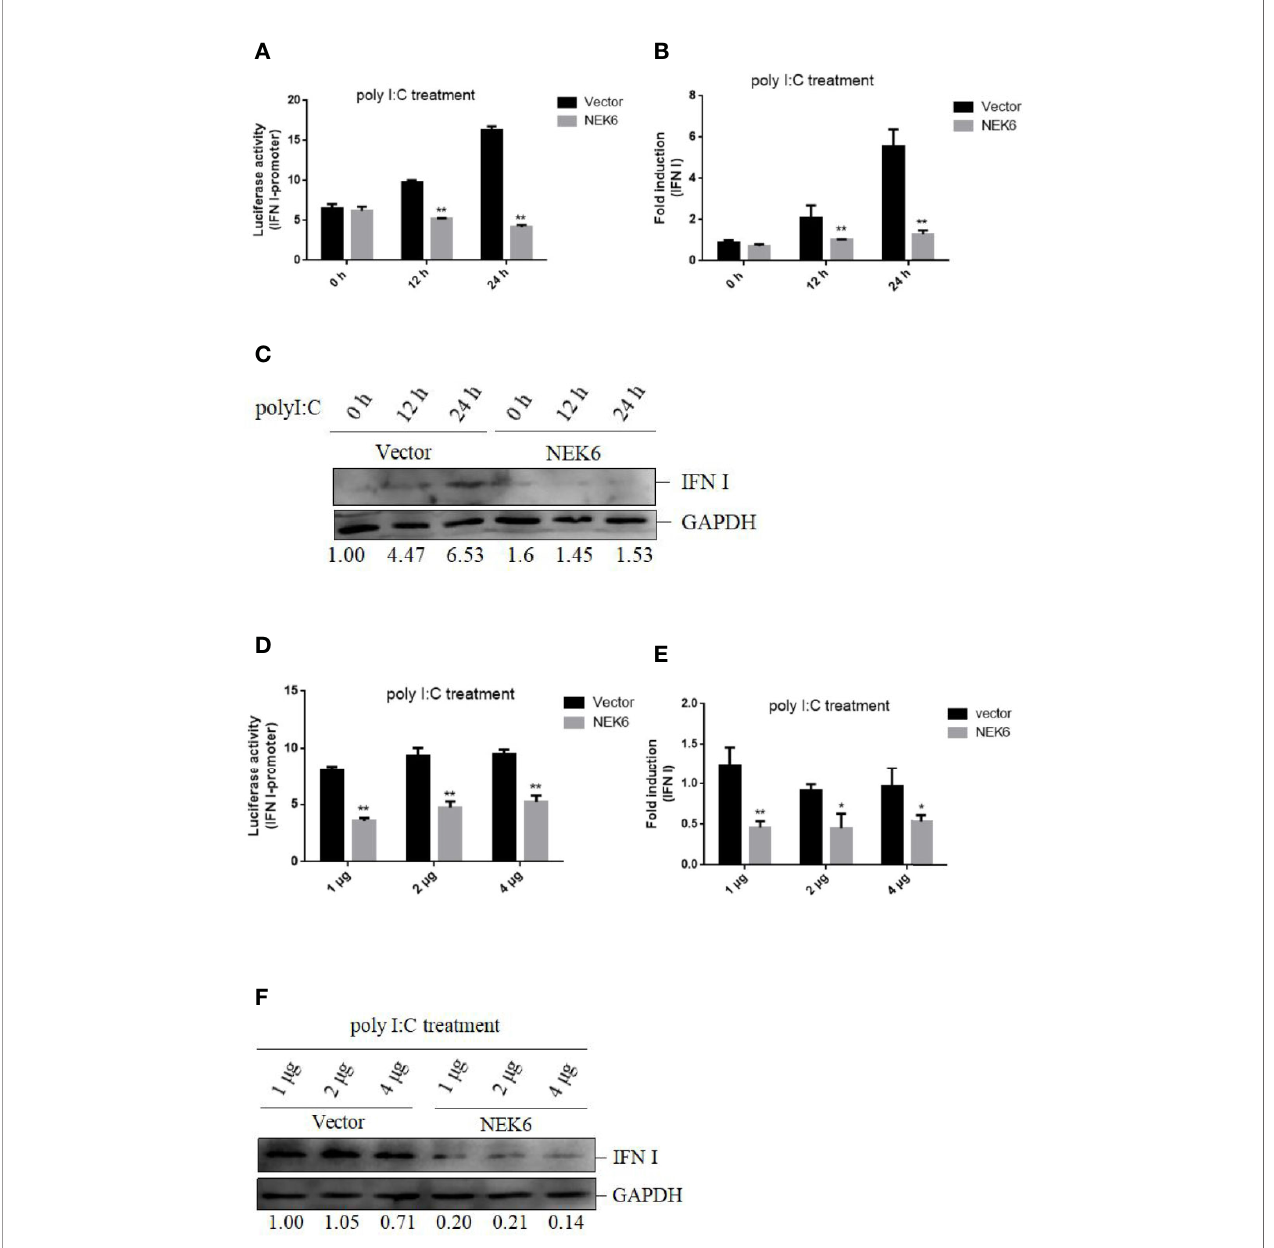
FIGURE 3 | CiNEK6 suppresses IFN I expression under poly I:C treatment. CIK cells were transfected with 2 m g of basic-pcDNA3.1 (Vector) and 2 m g of NEK6- pcDNA3.1, then they were treated with poly I:C for 0, 12, and 24 h. Dual-luciferase (A) , qRT-PCR (B) and Western blot (C) assays were used to detect IFN I expression. CIK cells were separately transfected with basic-pcDNA3.1 (Vector) and NEK6-pcDNA3.1 at three different dosages (1, 2, or 4 m g). Then the cells treated with poly I:C were incubated for 24 h. Dual-luciferase (D) , qRT-PCR (E) and Western blot (F) assays were used to detect IFN I expression. The molecular masses of IFN I and GAPDH are 18 and 38 kD, respectively. Image J was used to quantify relative protein expression levels (IFN I/GAPDH). *p < 0.05, **p <